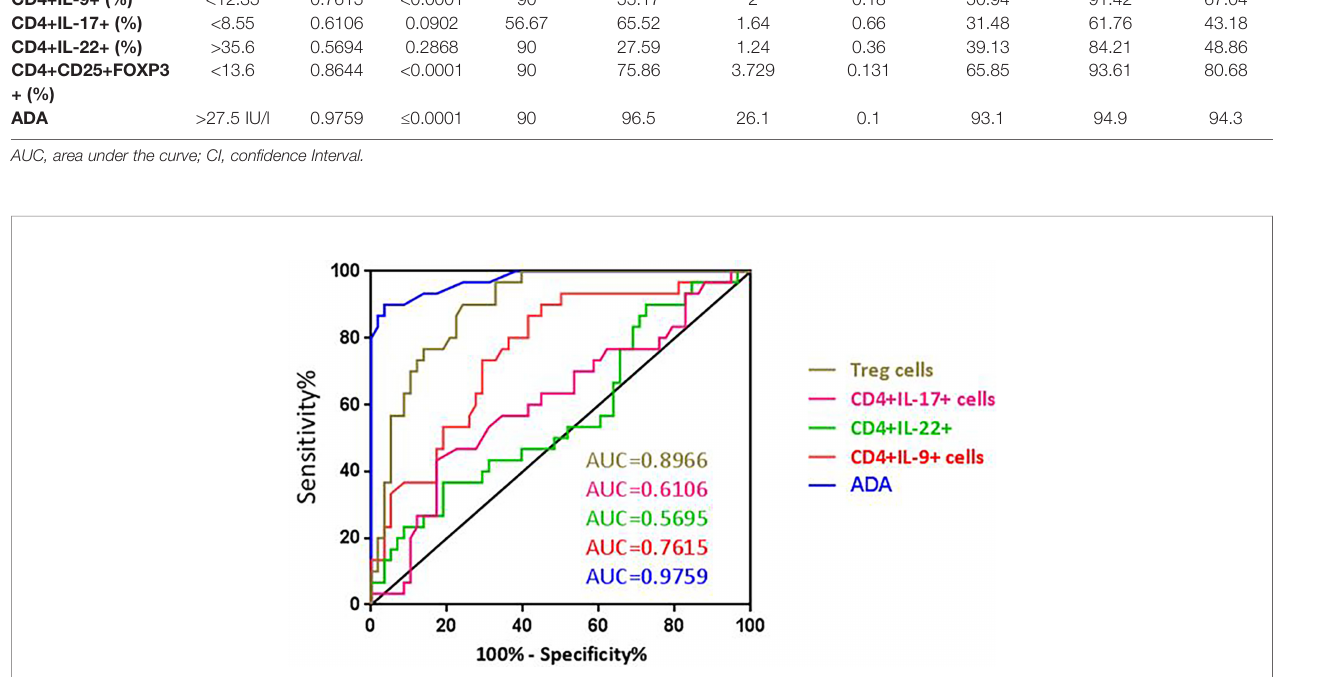
FIGURE 4 | ROC curve of ADA, CD4+IL-9+, CD4+IL-17+, CD4+IL-22+, and Treg cells for differential diagnosis of TPE (n = 30) versus non-TPE (n = 58).